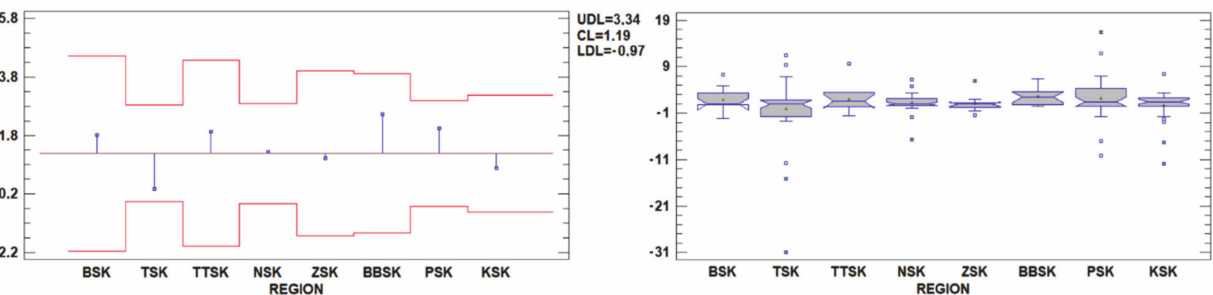
Figure 9. Comparison of the structure of results at the level of individual regions—Bonity index, businesses. Legend: BSK— Bratislava region, TSK—Trnava region, TTSK—Trenˇc í n region, NSK—Nitra region, ZSK—Žilina region, BBSK—Bansk á Bystrica region, PSK—Prešov region, KSK—Košice region; UDL—upper decision limit, CL—central line, LDL—lower decision